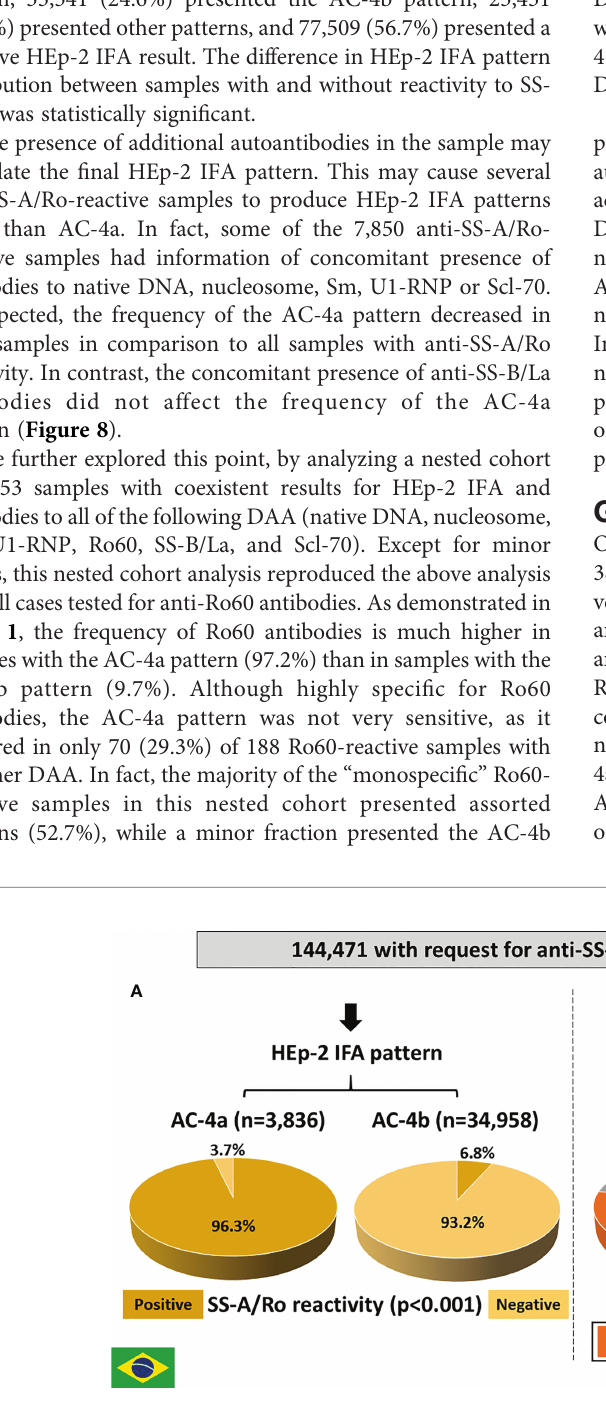
FIGURE 7 | Association between the AC4a pattern and antibodies to Ro60 according to data from Fleury Laboratory, São Paulo, Brazil. (A) HEp-2 IFA pattern perspective: most samples with the AC-4a pattern were positive, whereas most samples with the AC-4b were negative for anti-Ro60. (B) Anti-Ro60 antibody perspective: the AC-4a pattern is the most frequent pattern in samples positive for anti-Ro60 and was observed in only 0.1% of samples with no reactivity to